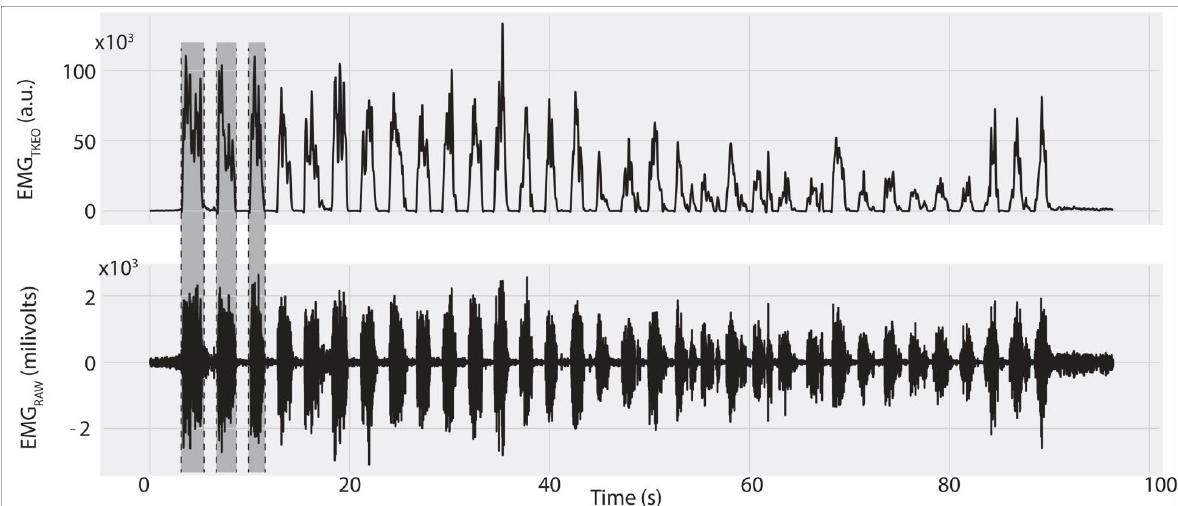
Figure 1. The EMG data analysis during the fatiguing protocol. (EMG TKEO— electromyography using the Teager Kaiser energy operator—related in arbitrary units—a.u.).